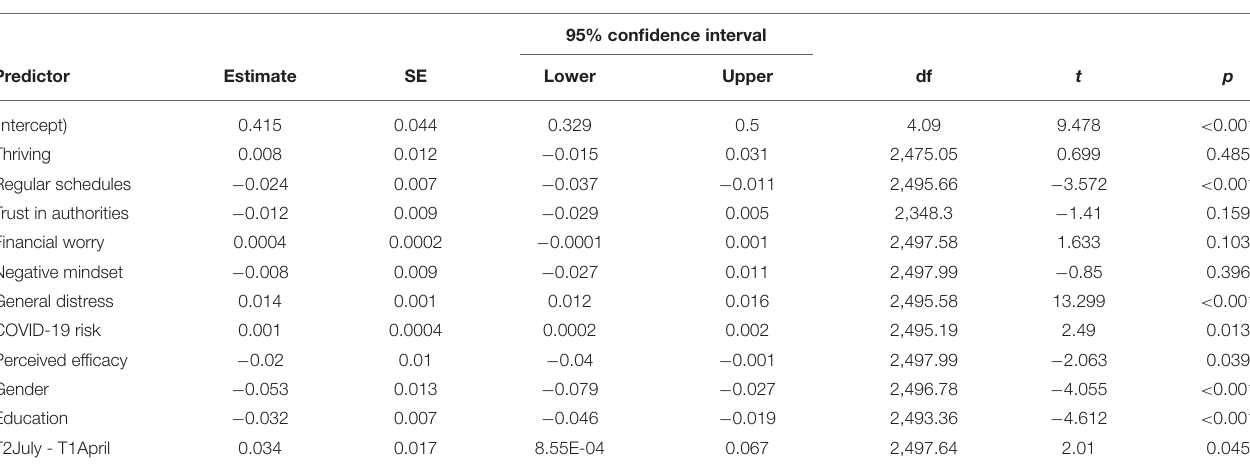
TABLE 3 | Fixed effects parameter estimates for